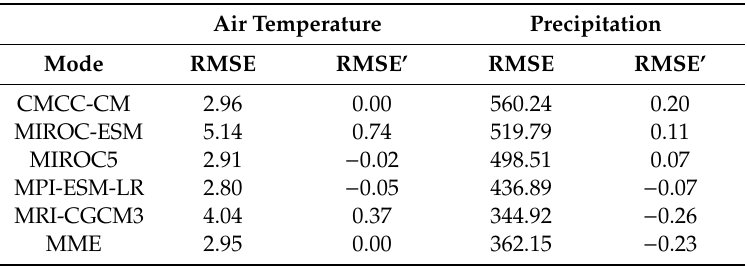
Table 3. Data sources used in the five di ff erent climate